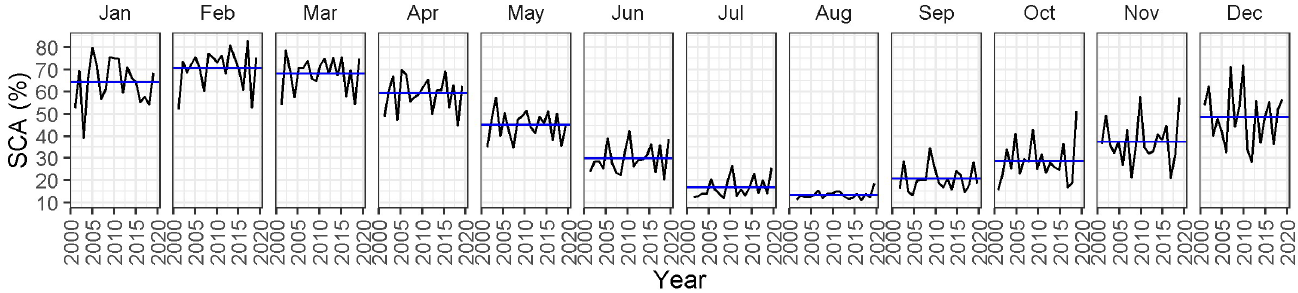
Figure 8. Monthly average percentages (black line) and overall monthly mean (blue line) of SCA for the entire study area of Ladakh over the period of 2000–2019.